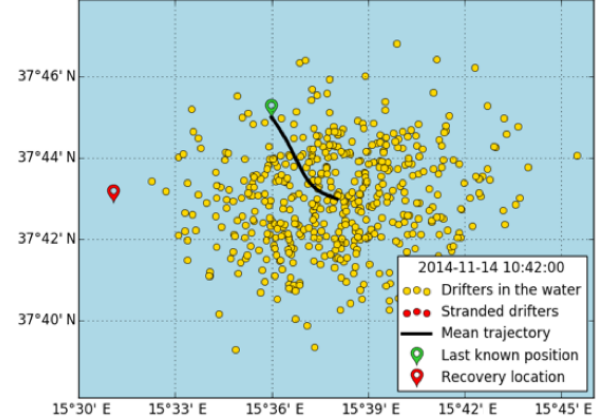
Figure 10. Results of the “Calabria1” simulation done using OCEAN-SAR showing the positions (yellow points) of the particles at the end of the simulation 11:00UTC of 14 November 2014. The red place marker indicates the position in which the raft was col- lected. The green place marker represent the position in which the raft was launched at sea and started drifting. The black line shows the mean trajectory of the simulated particles. During the exercise the wind speed ranged from approximately 3 to 10ms − 1 , predom- inantly in the south-south-west direction.